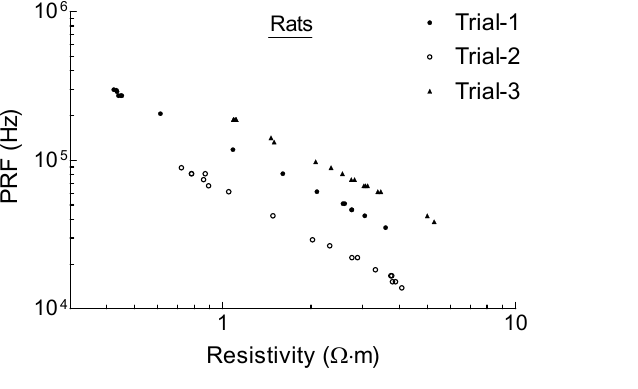
Fig. 11: PRF vs. resistivity plots for the five embryonic chick trials. In general, a good reproducibility of resistivities at a particular PRF in the trials was